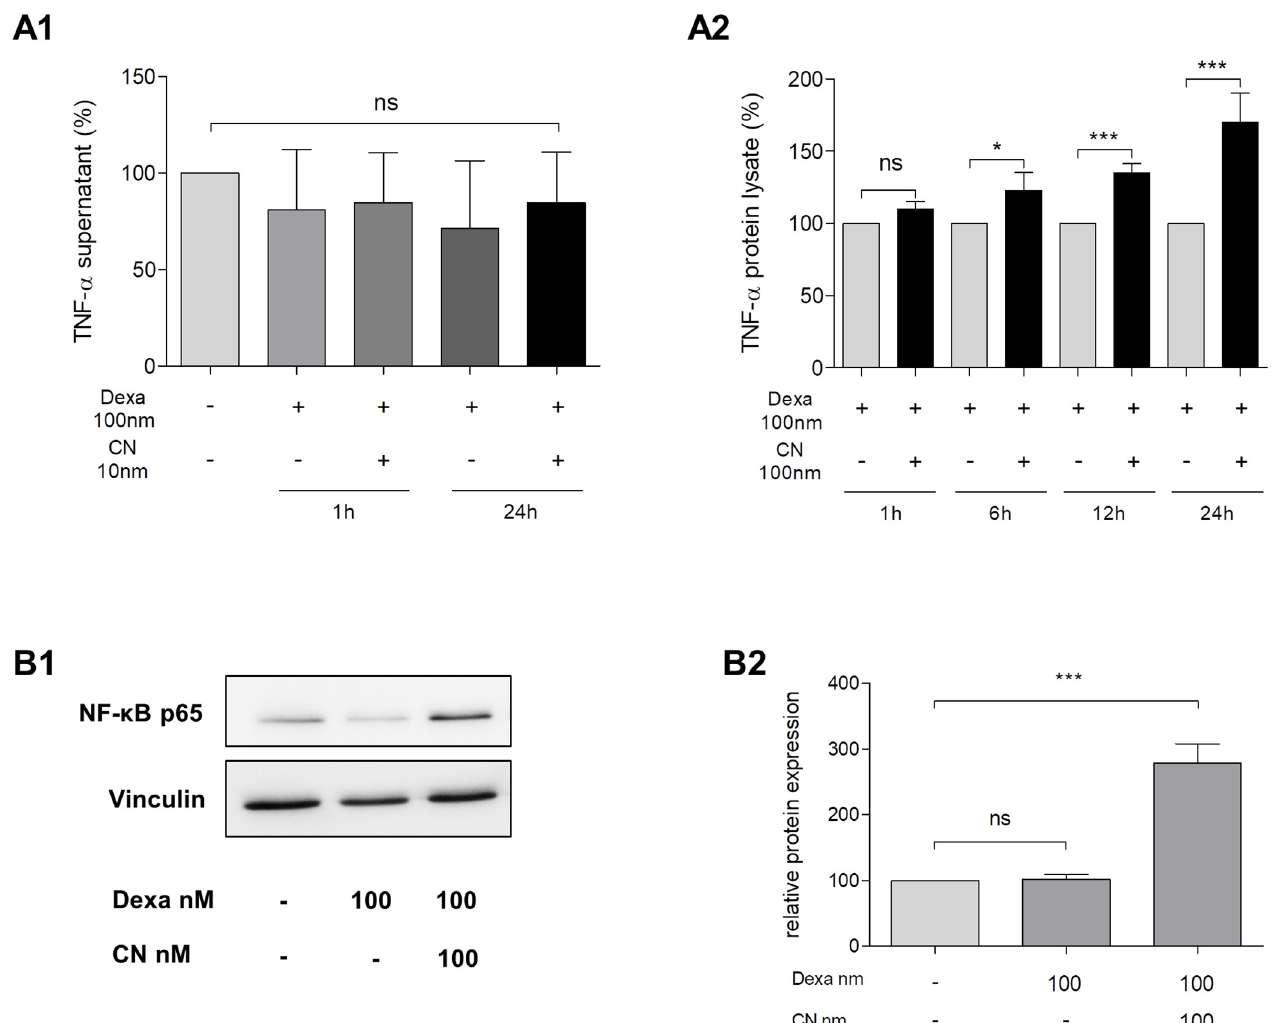
Fig 3. Effect of dexamethasone and cerulein on TNF- α and NF- κ B. A1-A2 , effect of dexamethasone (dexa) and cerulein (CN) on TNF- α . Cells were treated for 48 hours with 100 nM dexa (except controls in (A1) ), followed by stimulation of 100 nM CN for varying times. TNF- α concentrations were determined by ELISA in supernatant (A1) or protein lysate (A2) . Neither the use of dexa nor CN resulted in alterations of TNF- α release. However CN resulted in significant elevation of TNF- α production (A2) . B1-B2 , effect of dexa and CN on NF- κ B. Dexa did not influence p65 unit of NF- κ B on protein levels but CN significantly induced its expression 2.5 fold. Representative Western Blot images are shown in B1 , quantifications (B2) confirmed significant induction by CN. CN: cerulein, Dexa: dexamethasone. Results are expressed as mean ± S.D. of at least three independent experiments. ��� P < 0.001.